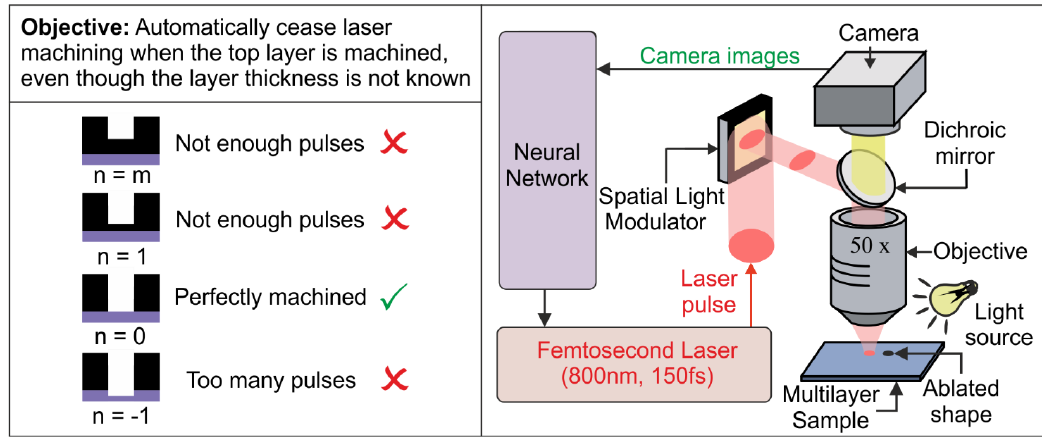
Fig. 1 Example application of deep learning for solving a practical laser machining